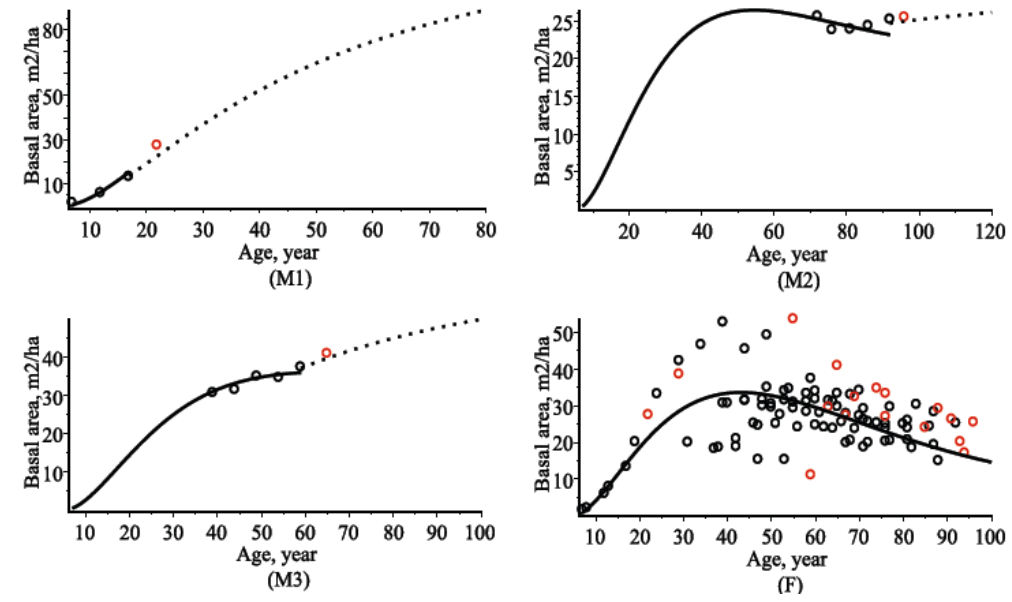
Figure 6. Evolution of basal area over age. ( M1 ) mixed effects scenario for the first stand; ( M2 ) mixed effects scenario for the second stand; ( M3 ) left–mixed effects scenario for the third stand; ( F ) fixed effects scenario for all stands; black solid line–stand basal area prediction curve; black dot line–stand basal area forecast curve; black circles – estimation dataset, red circles–validation (forecast) dataset. Table 4. Statistical indexes and p -values of the Shapiro-Wilk (SW p ) and Student (T p ) tests for the basal area (m 2 ha −1 ) Equations. 20 *.